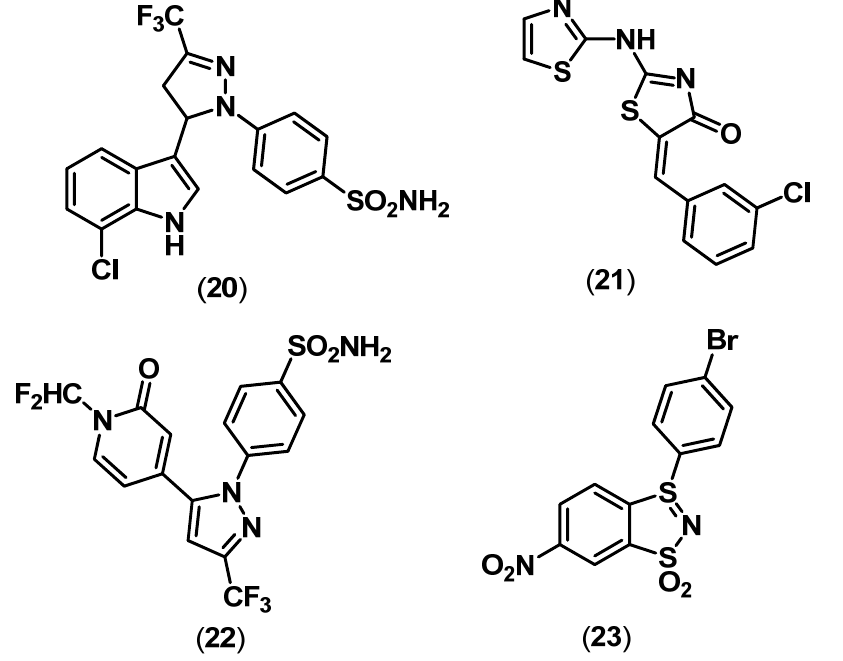
Figure 5. Chemical structures of some representative dual COX/LOX